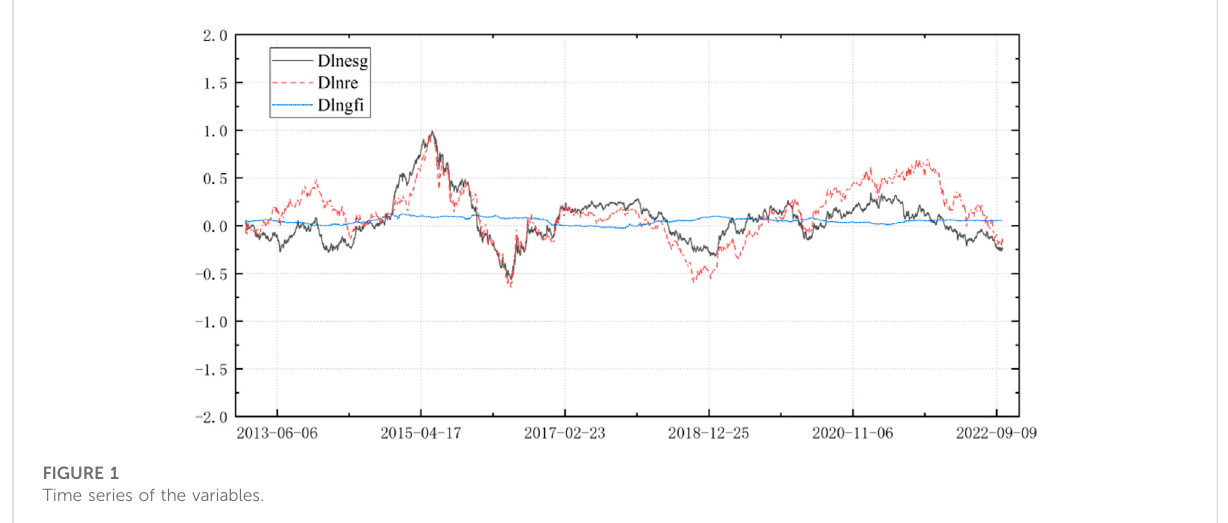
FIGURE 1 Time series of the